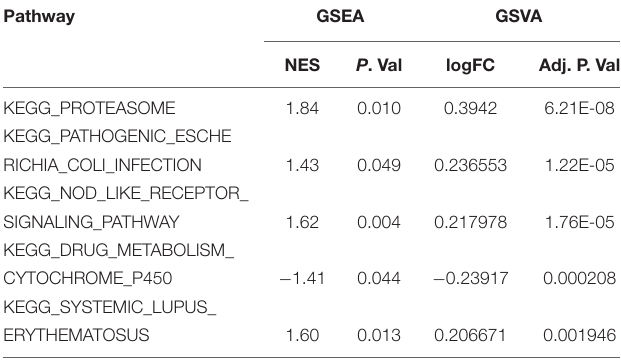
TABLE 2 | The pathways overlapped in results of GSEA and